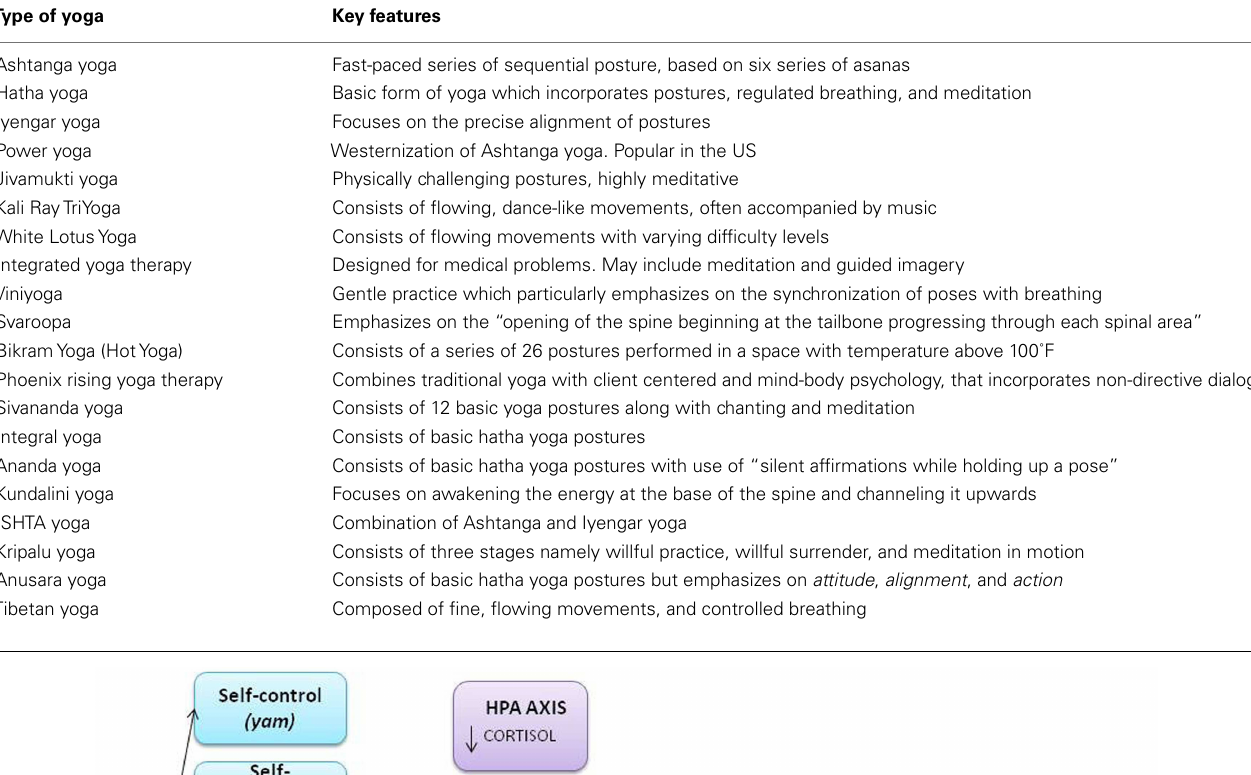
Table 1 |Table showing the key elements of the different forms of yoga (Cook, n.d.).